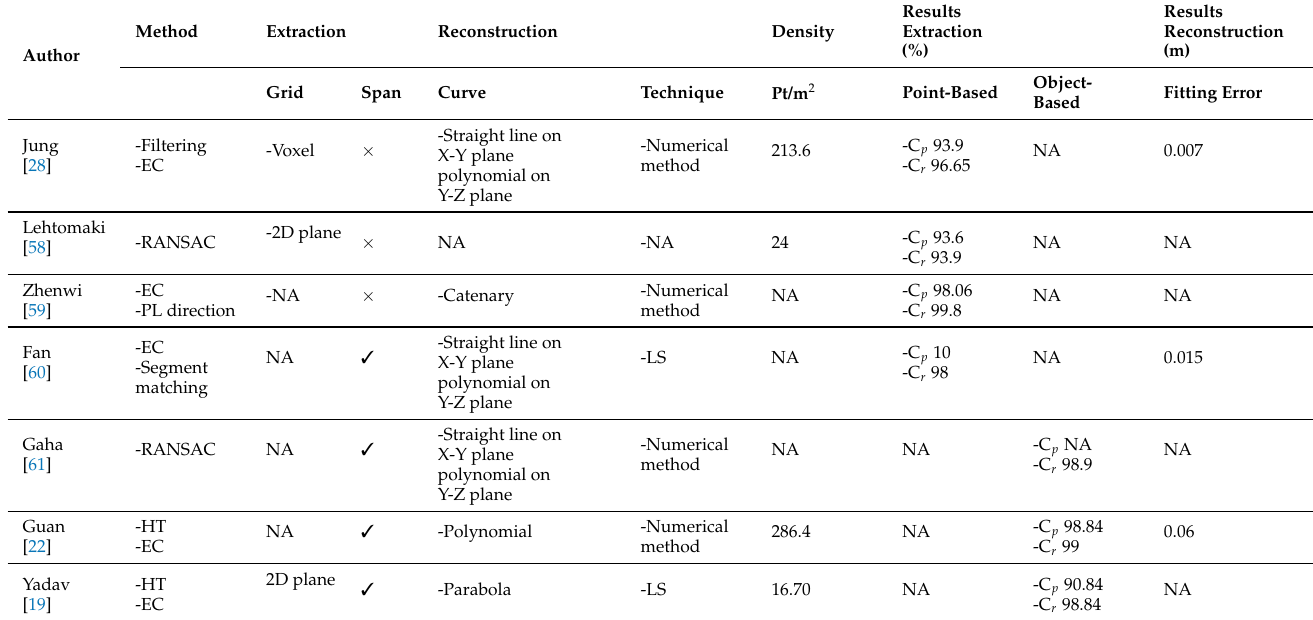
Table 5. Power line extraction using MLS. LS—Least square; PL—Power line; C p —Completeness C r —Correctness; EC—Euclidean clustering (EC); Ht—hough transform; NA—Not